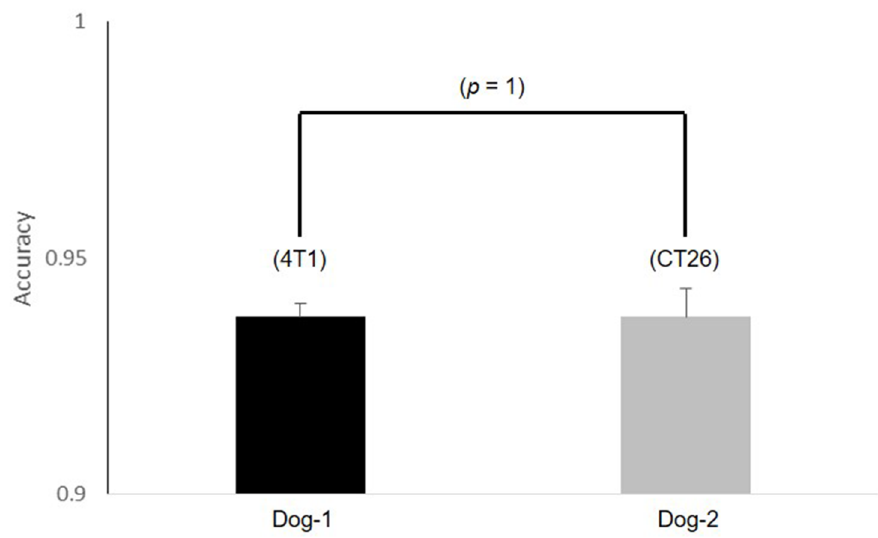
Fig 1. The statistical differences between two dogs for each training